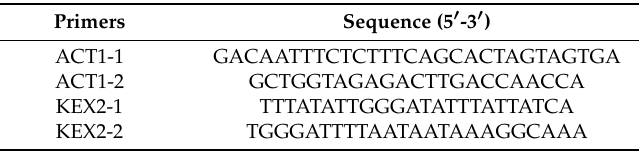
Table 2. List of primers used in the